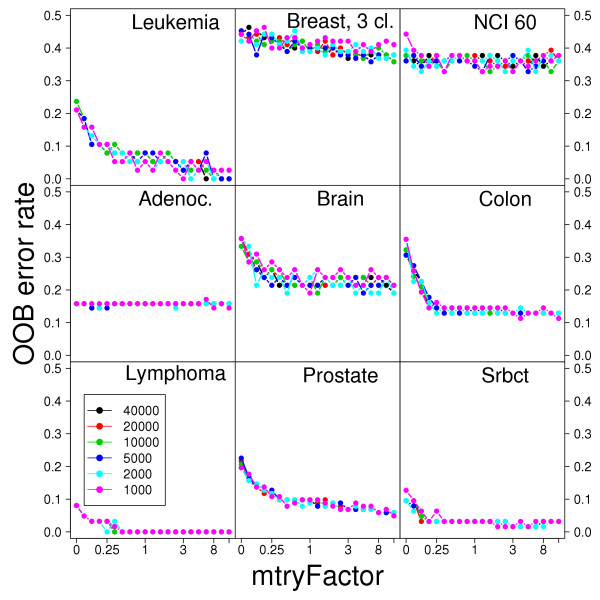
Out-of-Bag (OOB) vs mtryFactor for the nine microarray data sets. mtryFactor is the multiplicative factor of the default mtry (number⋅of⋅genes
 MathType@MTEF@5@5@+=feaafiart1ev1aaatCvAUfKttLearuWrP9MDH5MBPbIqV92AaeXatLxBI9gBaebbnrfifHhDYfgasaacH8akY=wiFfYdH8Gipec8Eeeu0xXdbba9frFj0=OqFfea0dXdd9vqai=hGuQ8kuc9pgc9s8qqaq=dirpe0xb9q8qiLsFr0=vr0=vr0dc8meaabaqaciGacaGaaeqabaqabeGadaaakeaadaGcaaqaaiabd6gaUjabdwha1jabd2gaTjabdkgaIjabdwgaLjabdkhaYjabgwSixlabd+gaVjabdAgaMjabgwSixlabdEgaNjabdwgaLjabd6gaUjabdwgaLjabdohaZbWcbeaaaaa@4332@); thus, an mtryFactor of 3 means the number of genes tried at each split is 3 * number⋅of⋅genes
 MathType@MTEF@5@5@+=feaafiart1ev1aaatCvAUfKttLearuWrP9MDH5MBPbIqV92AaeXatLxBI9gBaebbnrfifHhDYfgasaacH8akY=wiFfYdH8Gipec8Eeeu0xXdbba9frFj0=OqFfea0dXdd9vqai=hGuQ8kuc9pgc9s8qqaq=dirpe0xb9q8qiLsFr0=vr0=vr0dc8meaabaqaciGacaGaaeqabaqabeGadaaakeaadaGcaaqaaiabd6gaUjabdwha1jabd2gaTjabdkgaIjabdwgaLjabdkhaYjabgwSixlabd+gaVjabdAgaMjabgwSixlabdEgaNjabdwgaLjabd6gaUjabdwgaLjabdohaZbWcbeaaaaa@4332@; an mtryFactor = 0 means the number of genes tried was 1; the mtryFactors examined were = {0, 0.05, 0.1, 0.17, 0.25, 0.33, 0.5, 0.75, 0.8, 1, 1.15, 1.33, 1.5, 2, 3, 4, 5, 6, 8, 10, 13}. Results shown for six different ntree = {1000, 2000, 5000, 10000, 20000, 40000}, nodesize = 1.